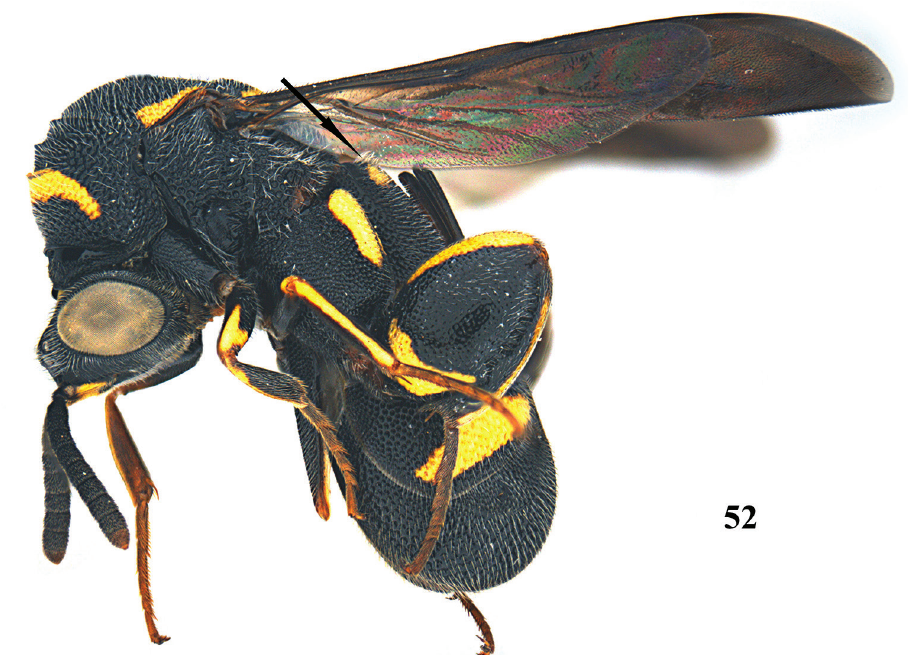
Figure 52. Leucospis femoricincta Bouček, ♀ from Guangdong, Yingxifenglin, habitus